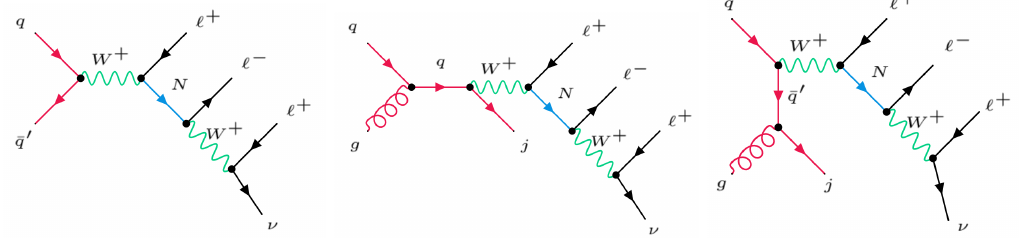
Figure 1 . The trilepton plus MET signal of a heavy Dirac neutrino at the hadron colliders, without any jet (left panel) or with only one jet (middle and right